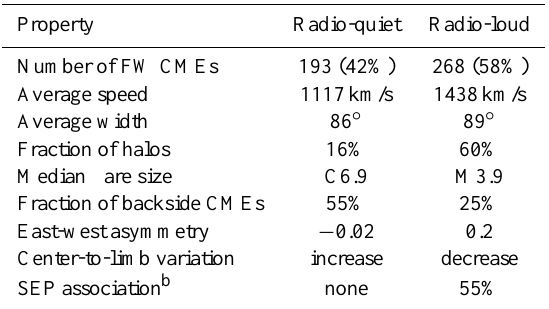
Table 1. Properties of radio-quiet and radio-loud fast and wide (FW) CMEs a .